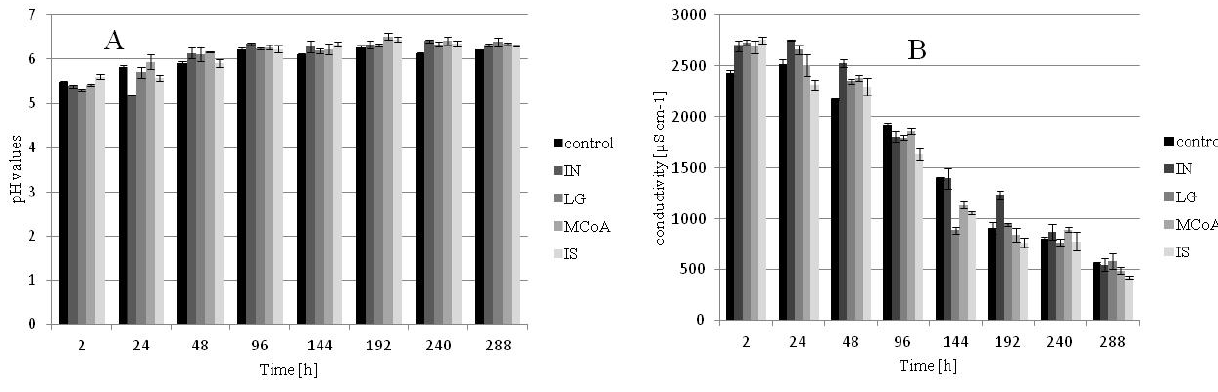
Figure 3. pH values ( A ) and conductivity ( B ) measured of the medium.